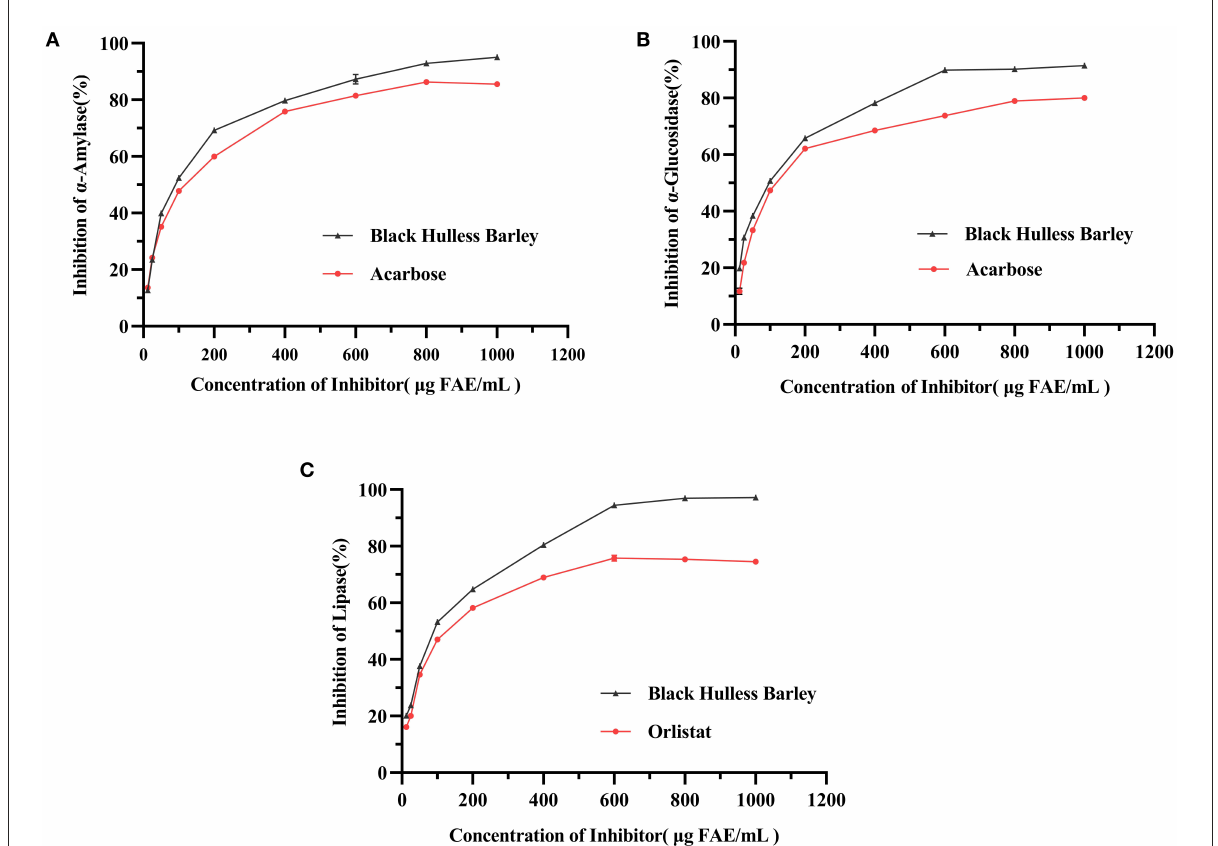
FIGURE1 The inhibitory activities of HBP extract on α -amylase (A) , α -glucosidase (B), and lipase (C) . The enzyme samples were treated with different concentrations of HBP extract, and the positive control groups were treated with acarbose (for α -amylase and α -GLU) and orlistat (for lipase). Data were expressed as mean measurements ( n =